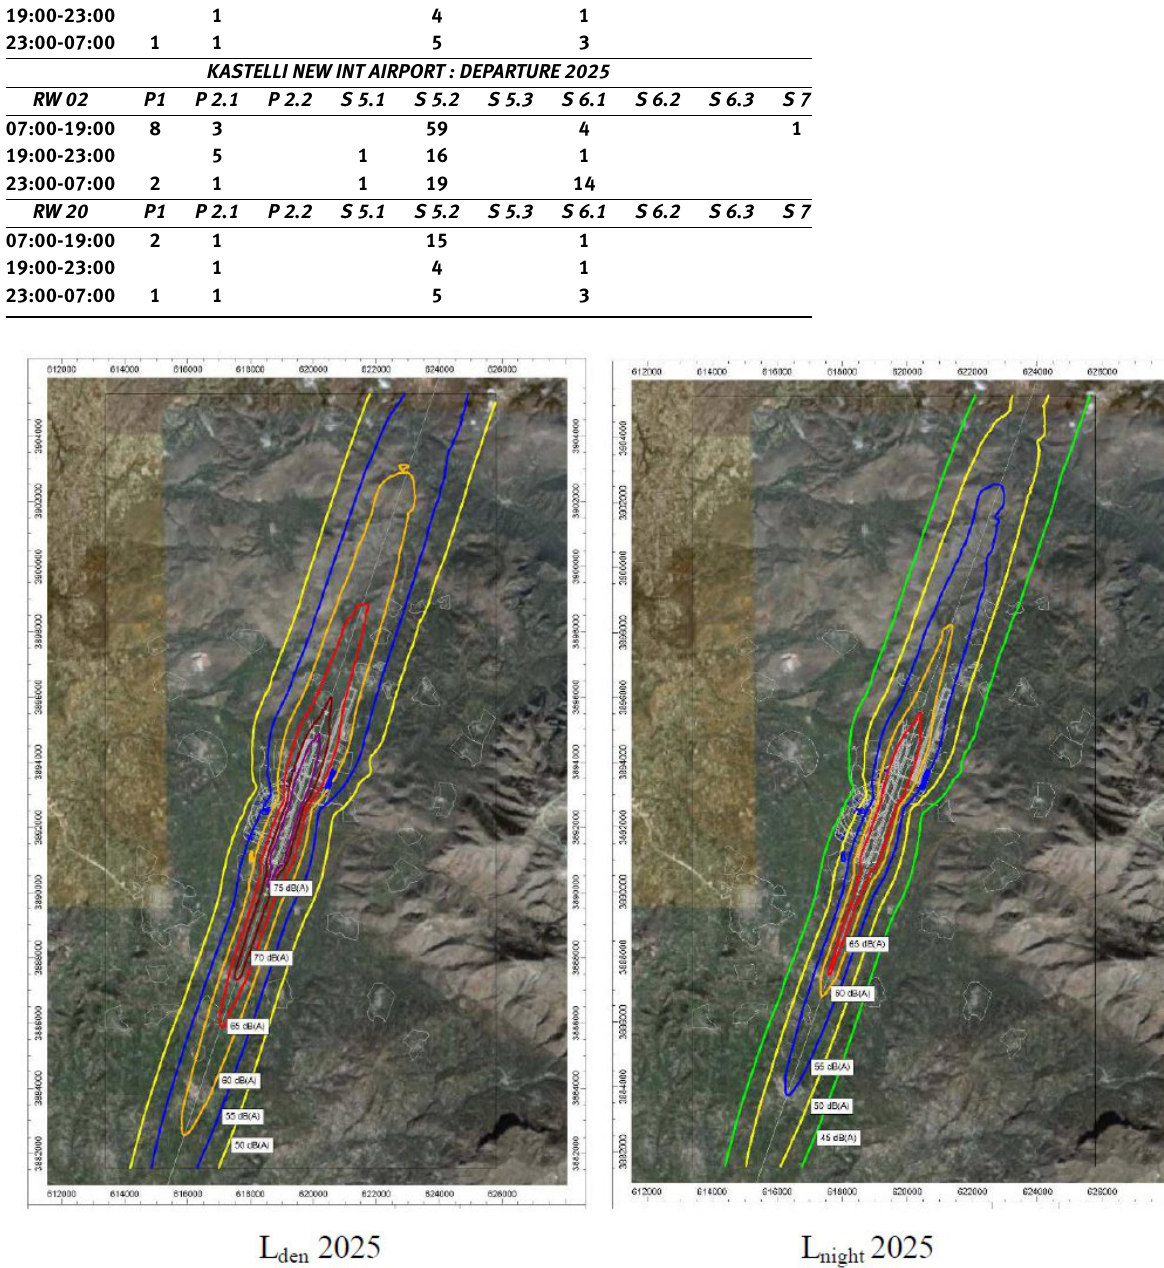
Fig. 16. New Kastelli Int. Airport-SNM 2025-Expected noise indices L den & L night